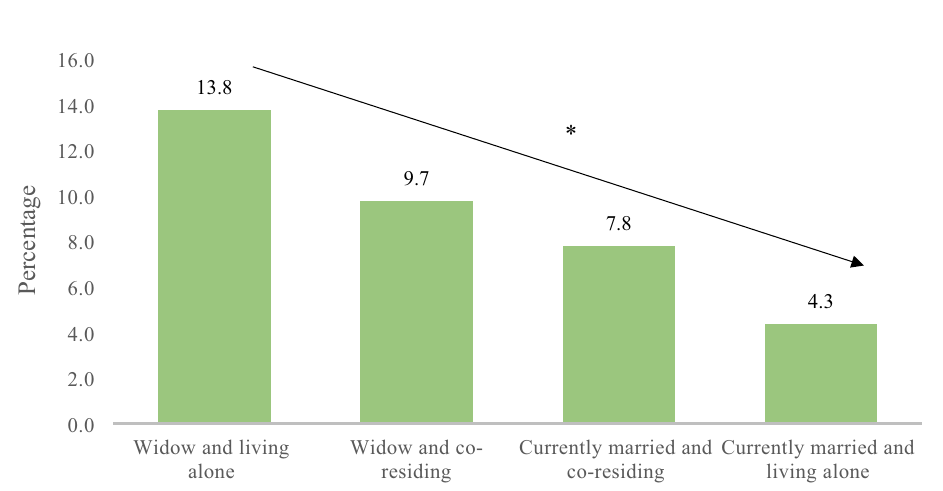
*The differences were significant based in chi-square test; The estimates are unadjusted estimates. Figure 3. Percentage of older adults suffering from depression by their marital status and living